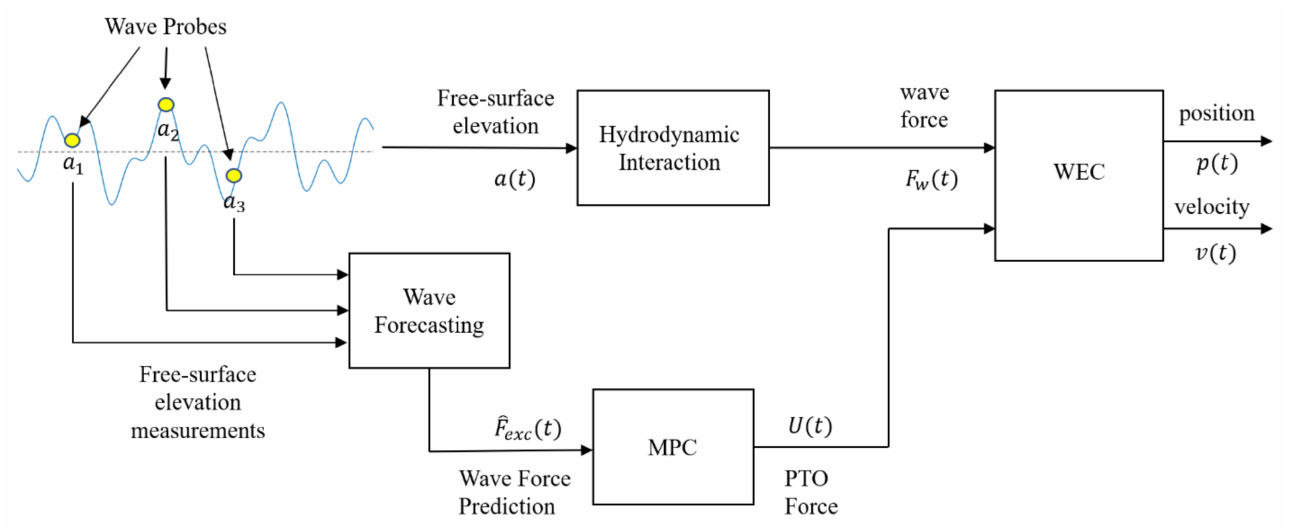
Figure 2. Architecture of Model Predictive